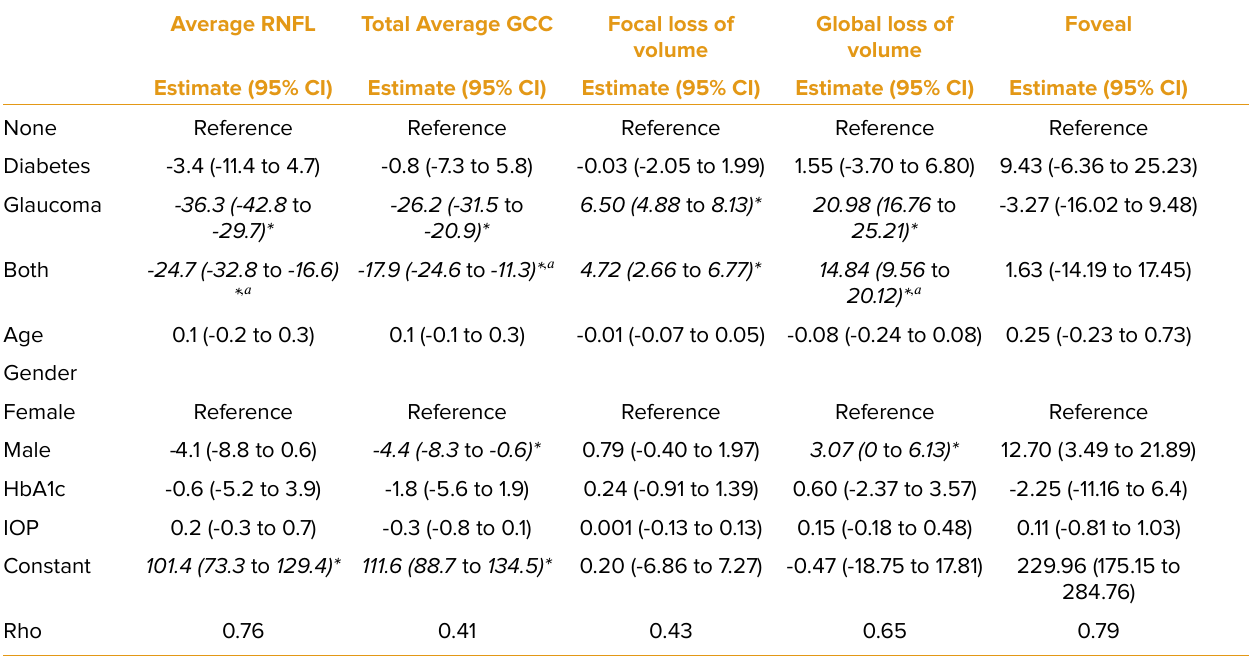
Table 4. Table showing the estimates and 95% confidence intervals (CI) multivariate analysis for retinal nerve fibre layer (RNFL), ganglion cell complex (GCC), focal loss of volume (FLV), global loss of volume (GLV), and Foveal in 172